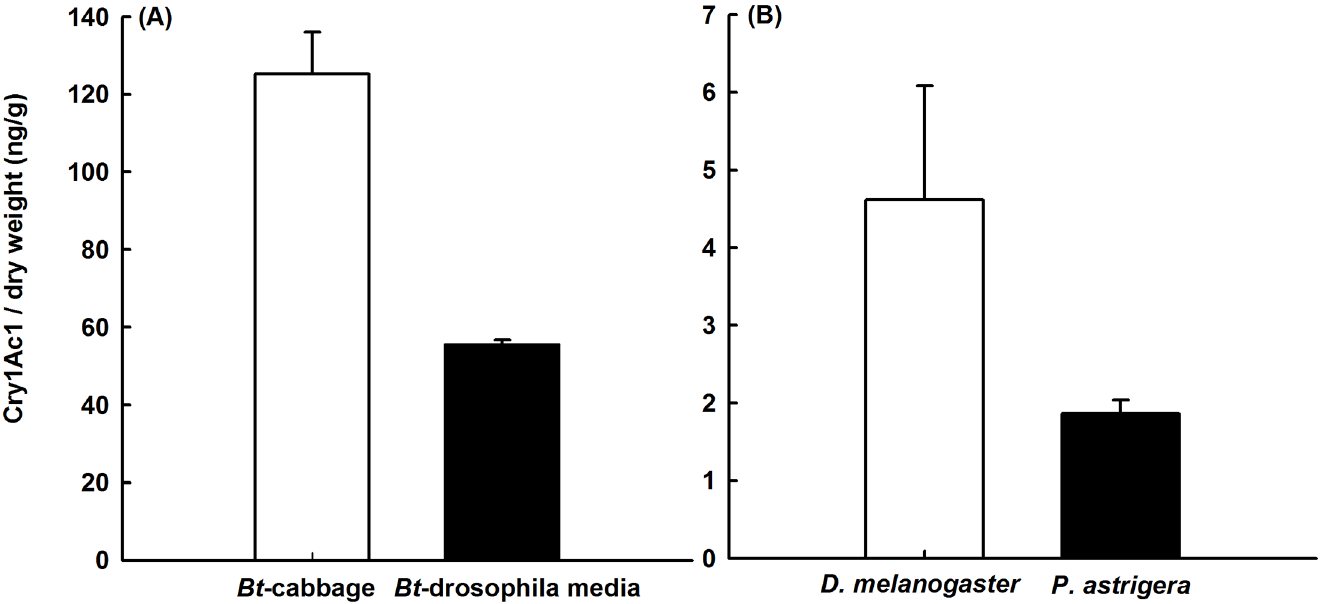
Fig 2. Cry1Ac1 concentrations (ng g -1 dry weight) in experimental samples. (A) Bt cabbage ( n = 3) or drosophila media containing Bt cabbage ( n = 4) and (B) D . melanogaster feeding on Bt cabbage ( n = 4) or P . astrigera that had preyed upon Bt cabbage-fed D . melanogaster ( n = 4). Data are means ± standard